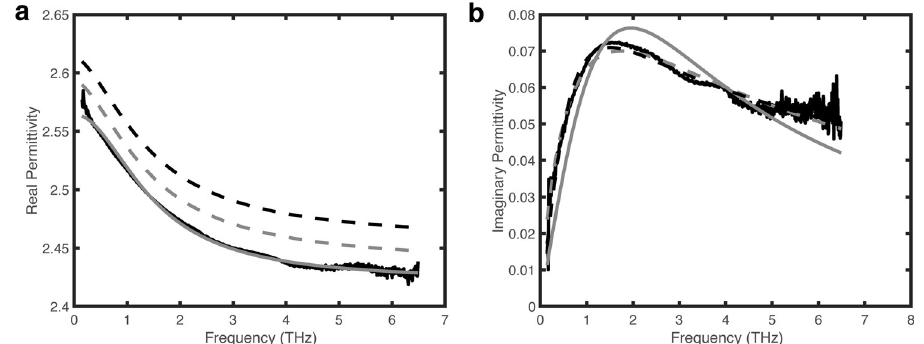
Fig 1. Data of real and imaginary part of permittivity. Data (black line) from Fig 3 of Sasaki et. al. Data at below 0.146 THz has been removed due to the poor signal-to-noise ratio. (a) Fit of real part of permittivity to Debye (solid gray line), Cole-Cole (dashed gray line), and Cole-Davidson (dashed black line) models. For clarity, the Cole-Cole and Cole-Davidson fits have been offset by 0.02 and 0.04, respectively. (b) Fit to imaginary part of permittivity using Debye, Cole-Cole, and Cole-Davidson